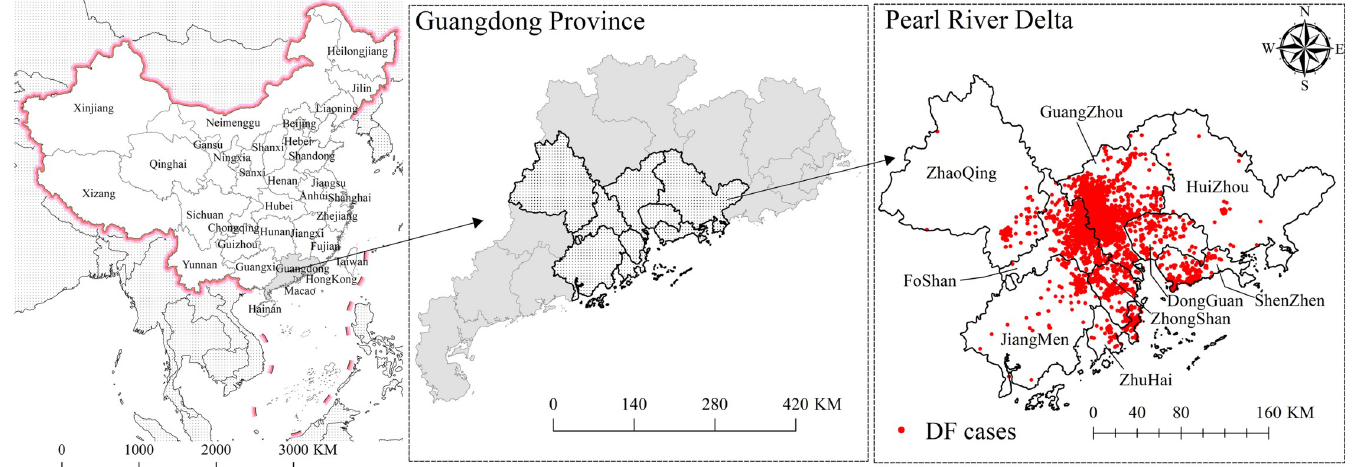
Fig 1. Study areas and the dengue cases of 2014 distributed in the PRD. https://www.resdc.cn/data.aspx?DATAID=201.